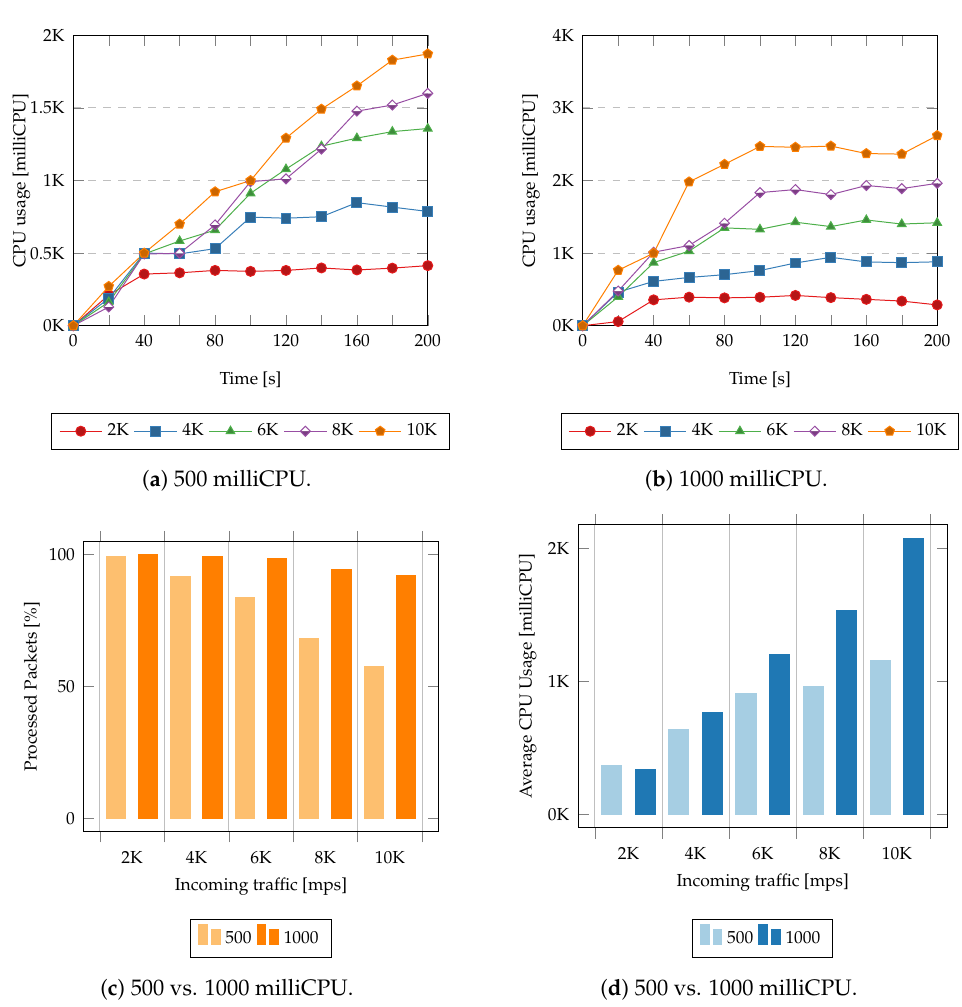
Figure 5. eINP module performing symmetric encryption with different milli-CPU